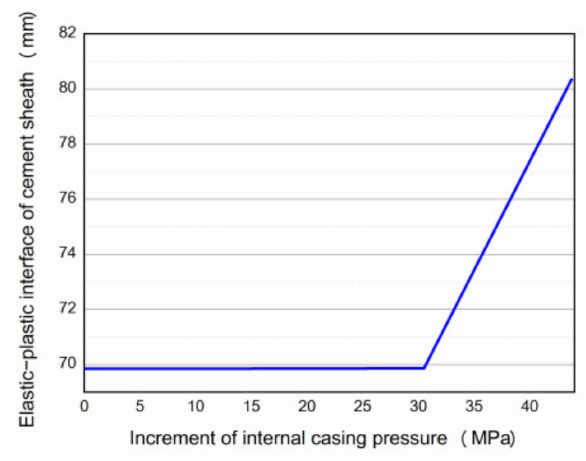
Figure 8. Elastic–plastic interface of the cement sheath during acid fracturing.